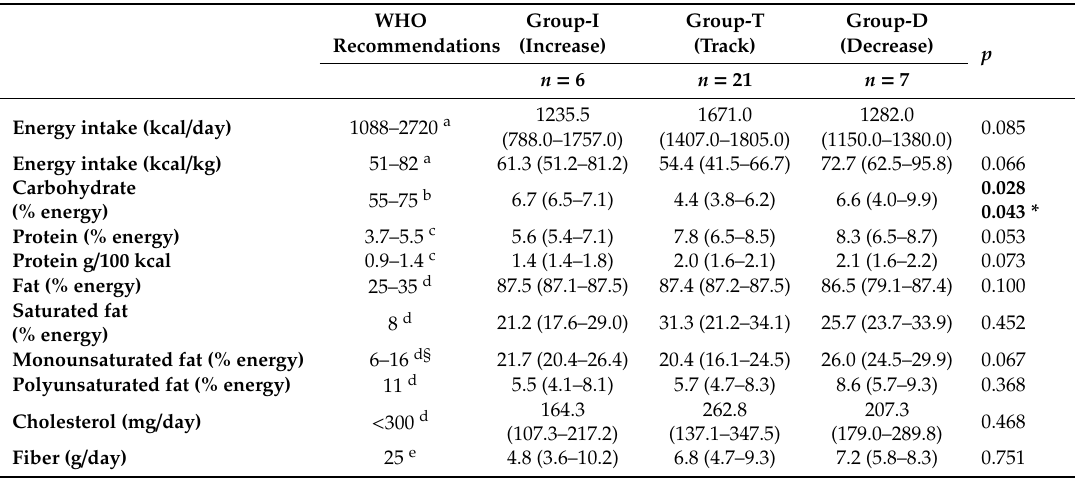
Ketogenic diet composition—in terms of energy and macronutrients—in the three growth